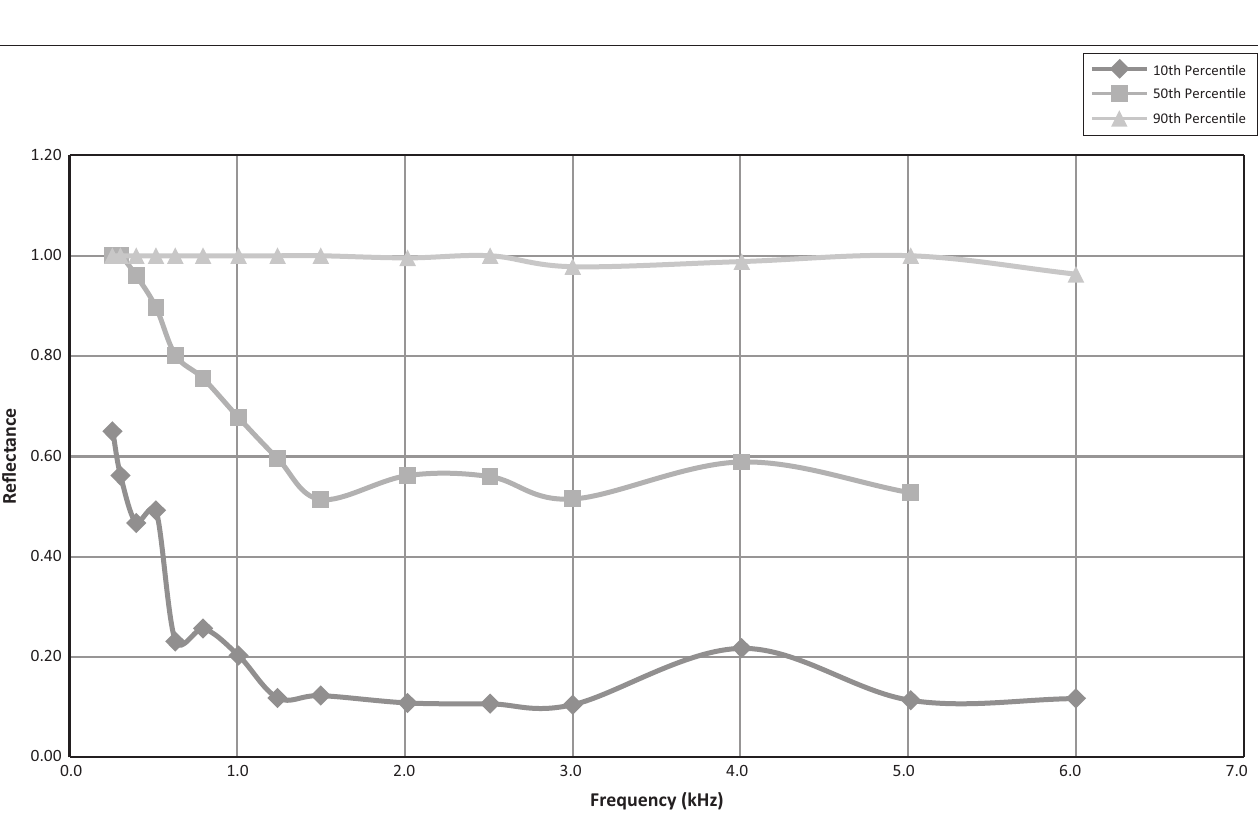
FIGURE 2: Reflectance data for chirp stimulus at individual frequencies ( n = 75